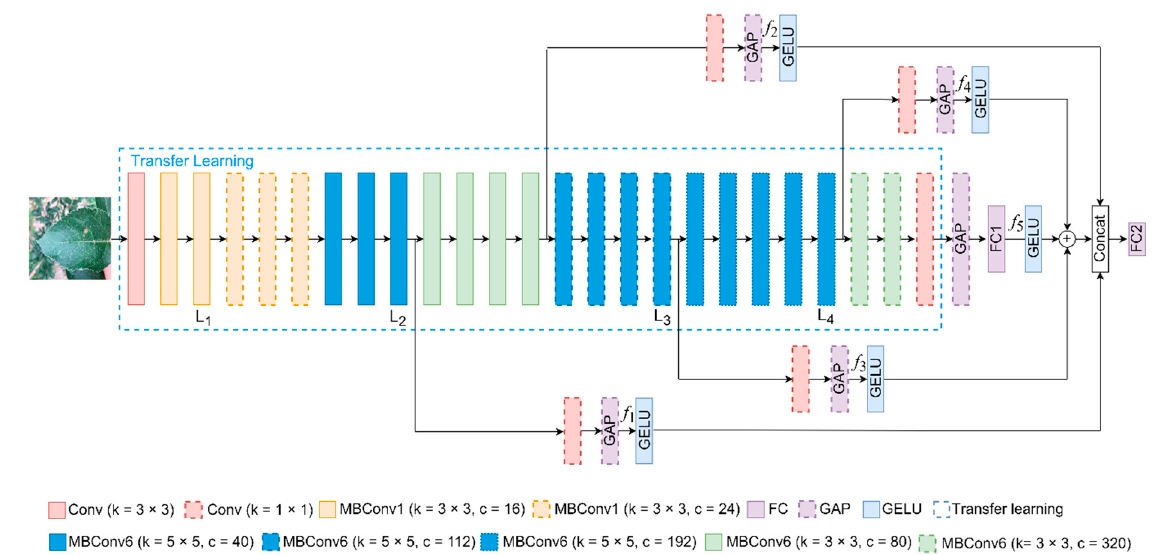
Figure 6. Proposed EfficientNet-MG for ALD identification.